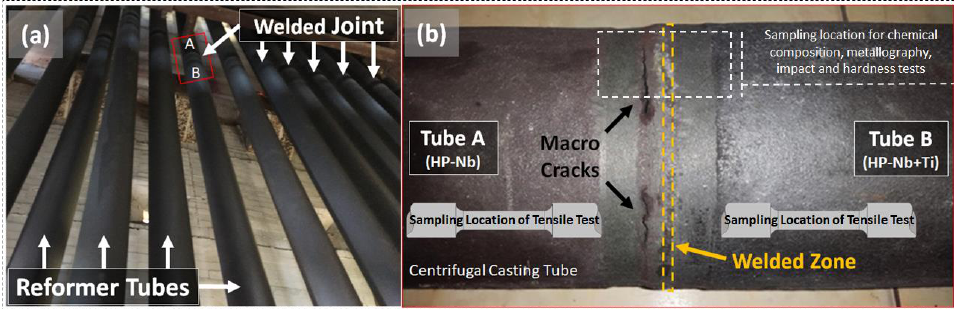
Figure 1. ( a ) Centrifugal cast tubes in the reformer furnace and ( b ) latitudinal cracks formed perpen- dicular to the stress direction on Tube